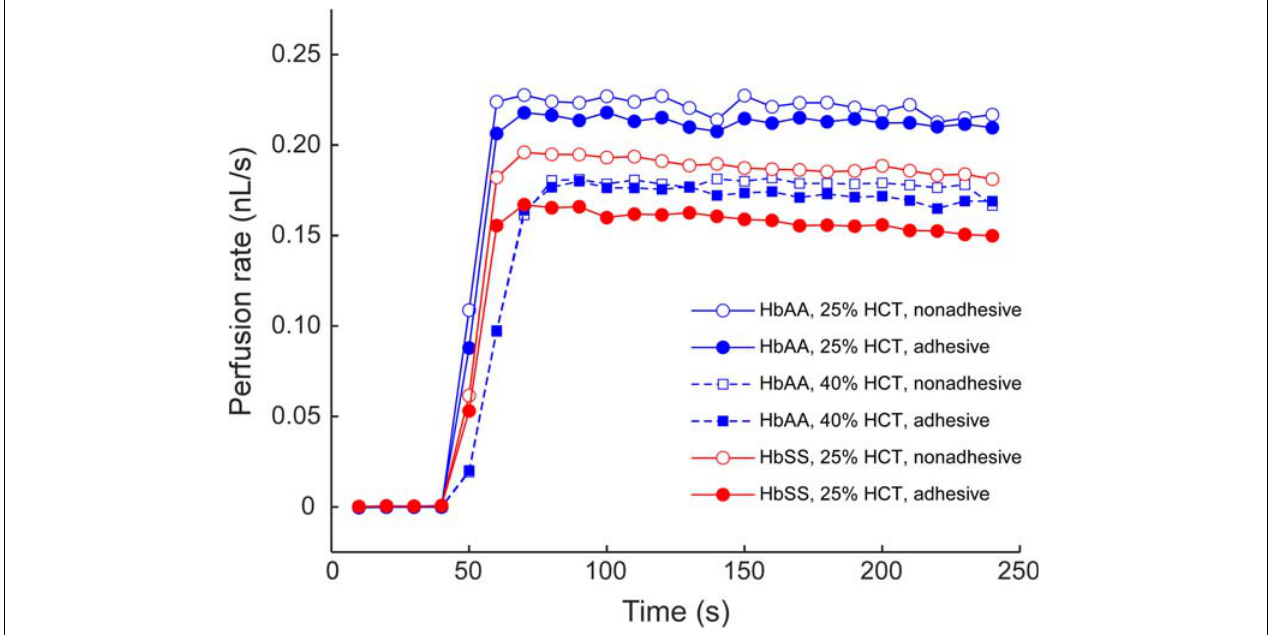
FIGURE 2 | An example of the AMVN perfusion rate traces for samples of sickle (HbSS) and normal (HbAA) RBCs at 25 and 40% HCT, in either adhesive (LN) or non-adhesive (mPEG) networks. A constant HCT of approximately 25% was chosen for all subsequent experiments.